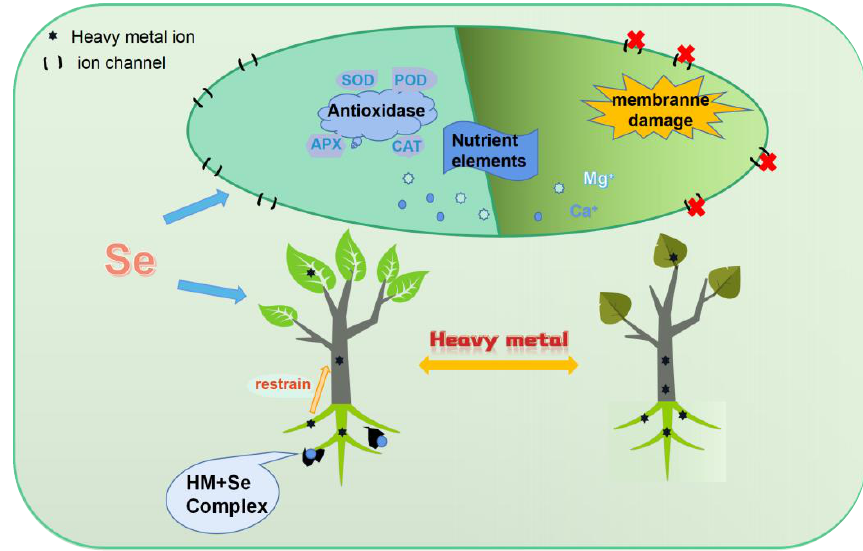
Figure 4. Patterns of Se mitigating heavy metal stress in plants. The left part shows Se treatment and the right is non-seleniferous treatment in plants under heavy metal stress.